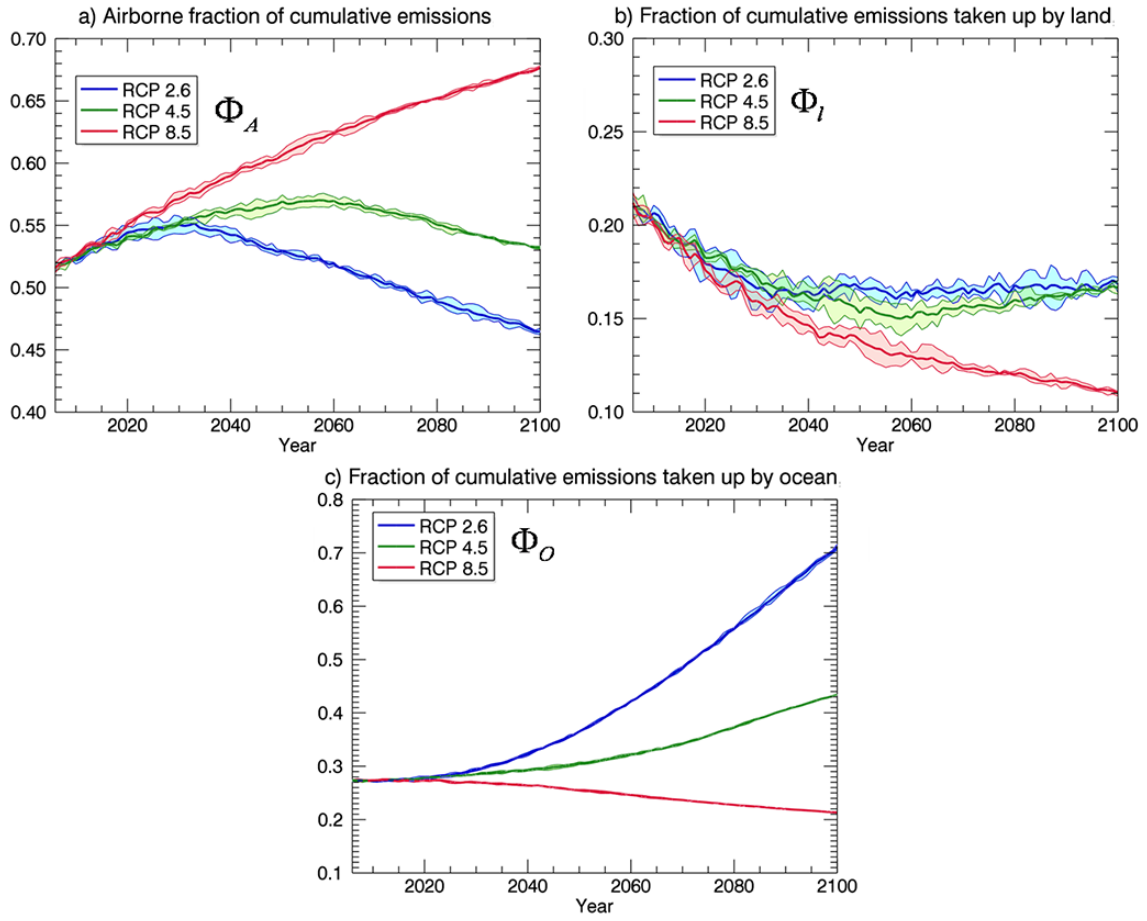
Figure 2. Airborne fraction of cumulative fossil fuel and LUC emissions ( 8 A , a ) and fraction of these cumulative emissions taken up by land ( 8 l , b ) and ocean ( 8 O , c ) for the 2006–2100 period and for the three RCP scenarios. The year 2005 values are calculated using results from the CanESM2 historical simulations as reported in Arora et al.